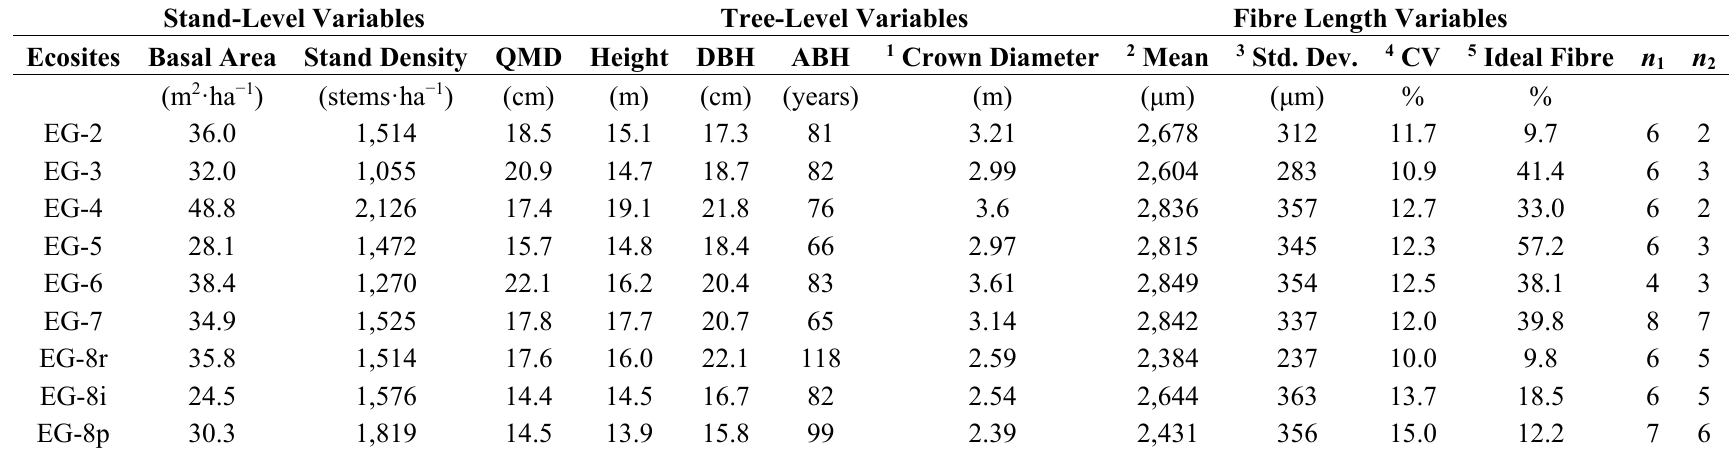
Table 1. Descriptive statistics for sample population of black spruce ( Picea mariana ) trees representing nine different ecosite groups collected in the boreal forest of northeastern Ontario in